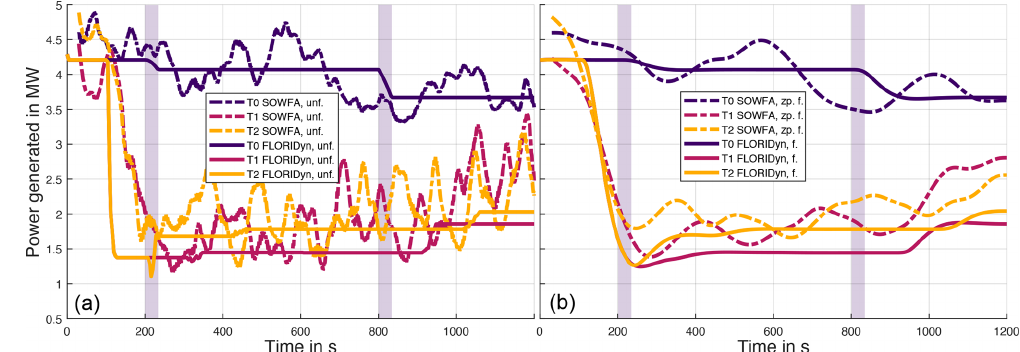
Figure 7. Comparison of the power generated in SOWFA and in FLORIDyn with changing yaw angles. The transparent bars indicate the time window in which turbine T0 increases its yaw angle by 10 ◦ . Panel (a) shows the unfiltered data, and panel (b) shows the filtered data. The SOWFA data are filtered with a zero-phase (noncausal) low-pass filter and FLORIDyn with a causal low-pass filter.